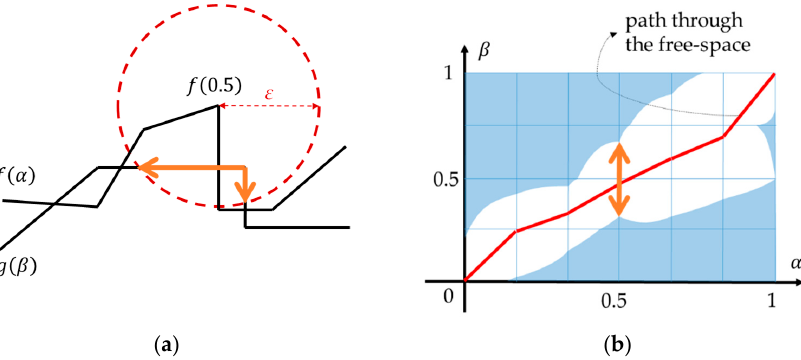
Figure 2. An example of ( a ) two curves (cid:1858) and (cid:1859) and ( b ) their free-space diagram for distance threshold (cid:2013) . Two curves were parameterized with (cid:2009) and (cid:2010) . The thick arrowed lines are the part of (cid:1859) within distance (cid:2013) from (cid:1858)(cid:4666)0.5(cid:4667) . There exists a path, depicted as a thick solid line, through the free space in the diagram